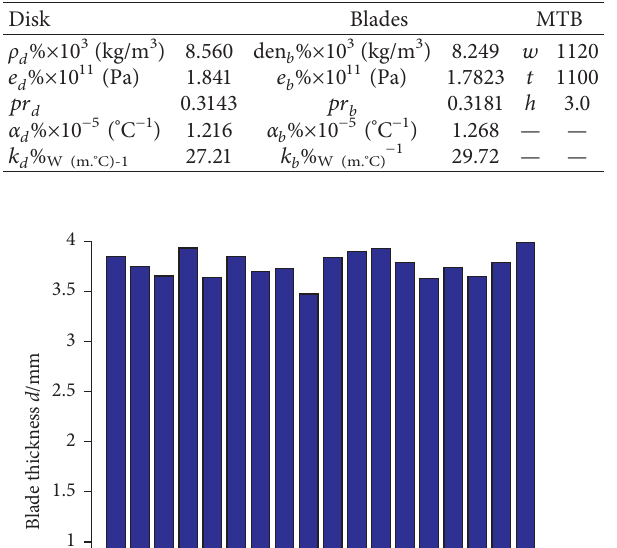
Table 1: Parameters of MTB.